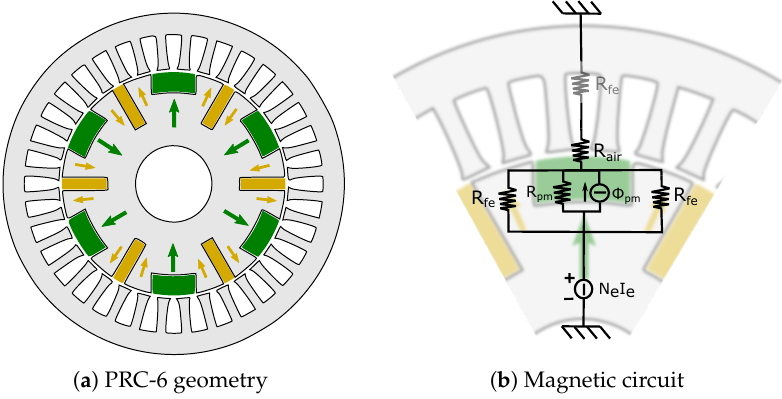
Figure 7. PRC-6 configuration: geometry and magnetic circuit.